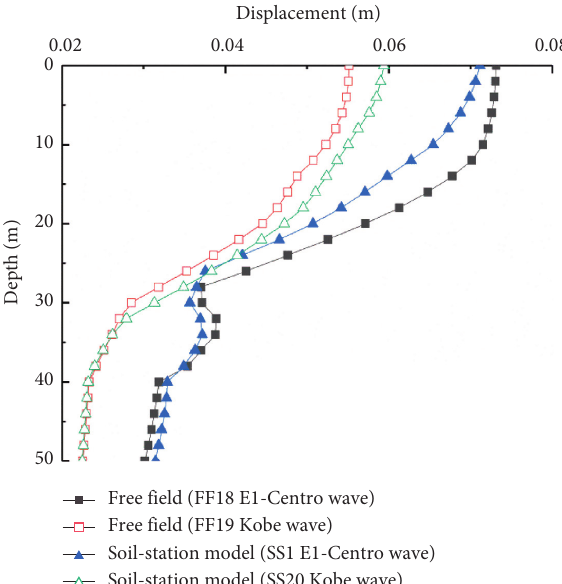
Figure 11: Displacement of soil in depth direction under different seismic waves.